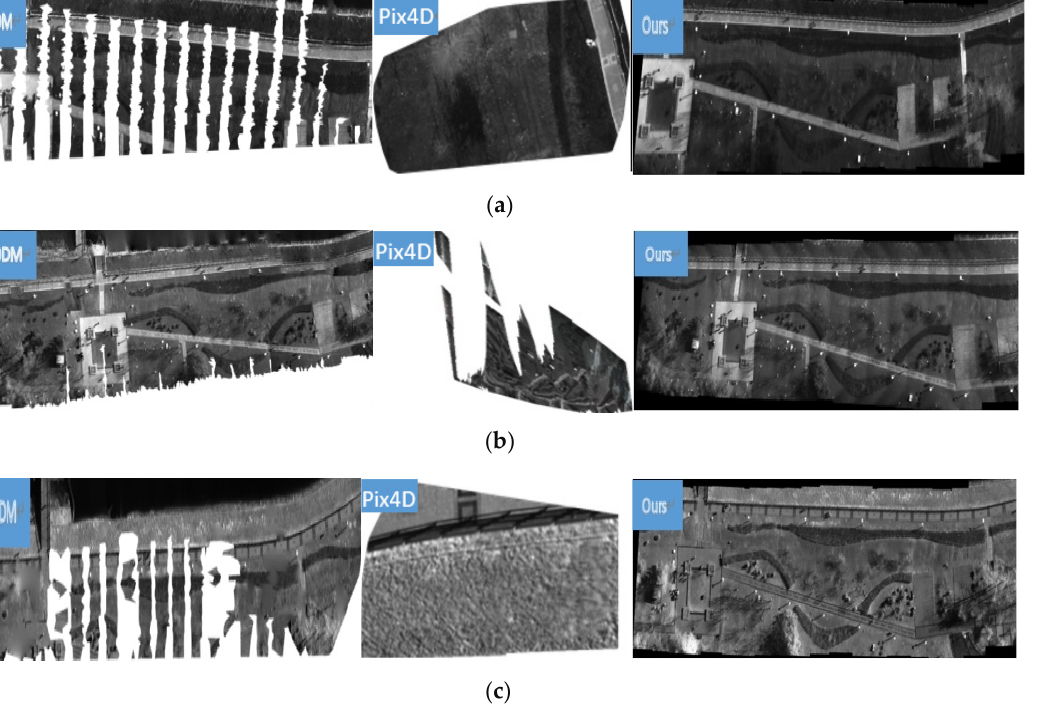
Figure 7. Stitching results of ODM, Pix4D, and proposed method on BGNIR multispectral aerial image dataset. ( a ) Panoramas for ODM, Pix4D, and ours on blue spectrum aerial images; ( b ) Panoramas for ODM, Pix4D, and ours on green spectrum aerial images; ( c ) Panoramas for ODM, Pix4D, and ours on near infrared spectral aerial images.